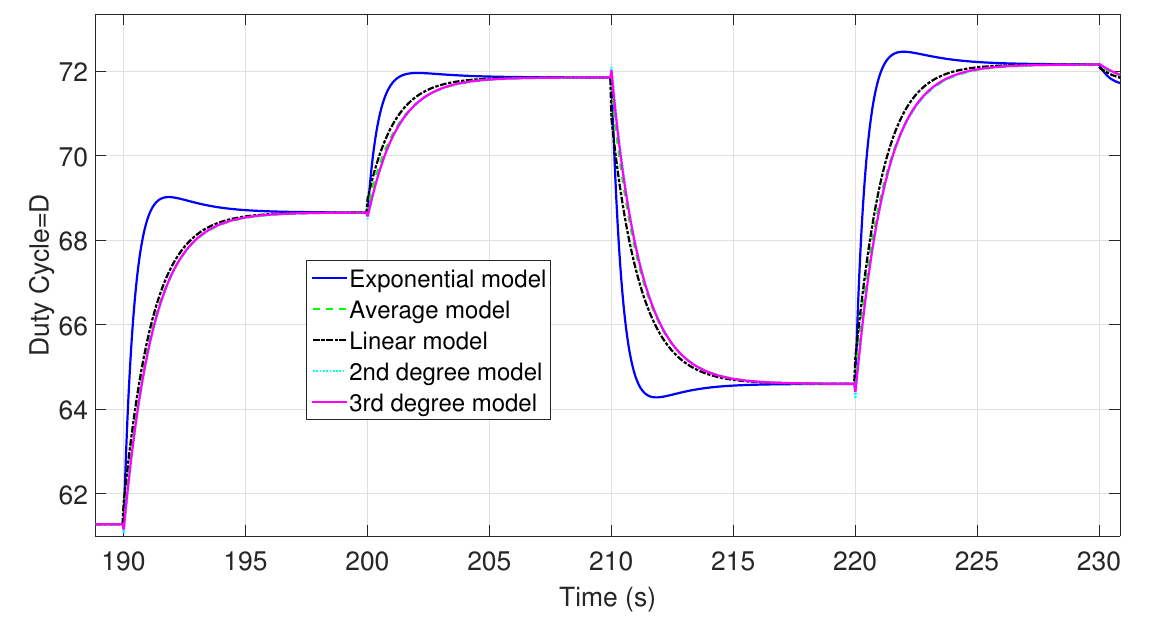
Figure 10. Duty cycle for the proposed models from 190 to 230 s.